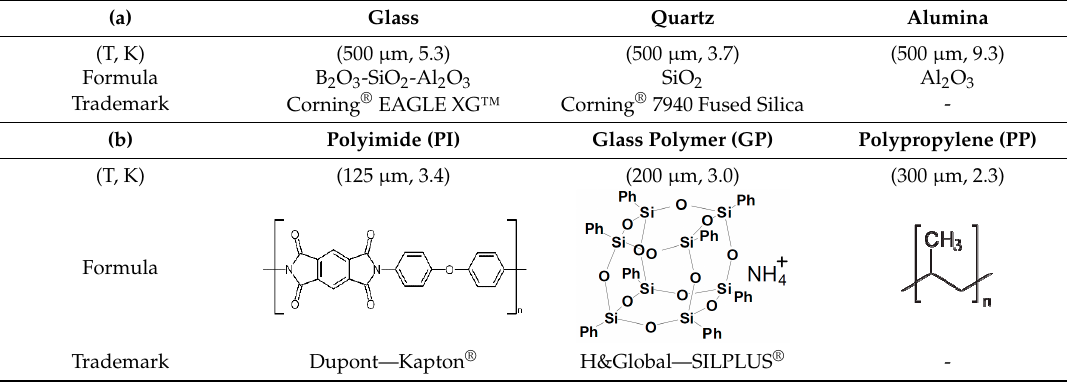
Table 1. Formula of dielectric materials: ( a ) Solid plates and ( b ) Flexible polymer films. (a) Glass Quartz